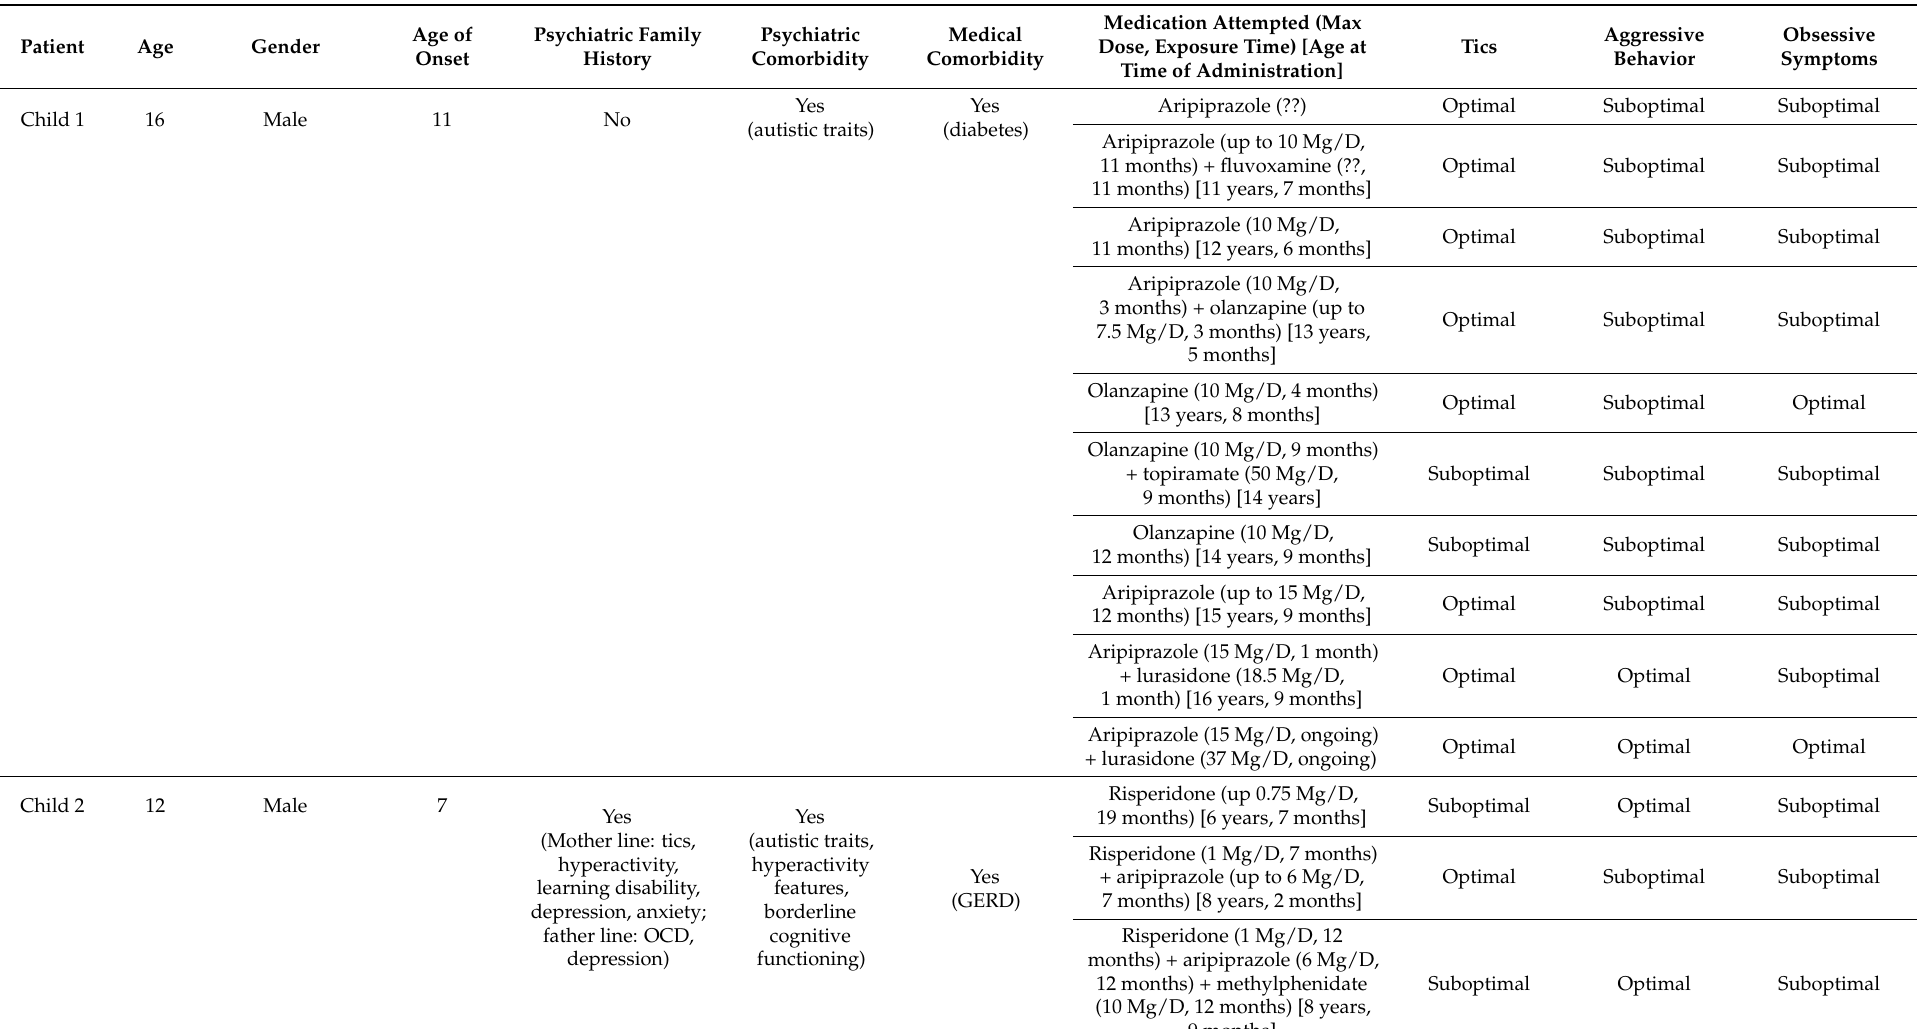
Table 1. Flow chart of pharmacological intervention up to lurasidone add-on therapy to risperidone or aripiprazole in six children/adolescents with Tourette